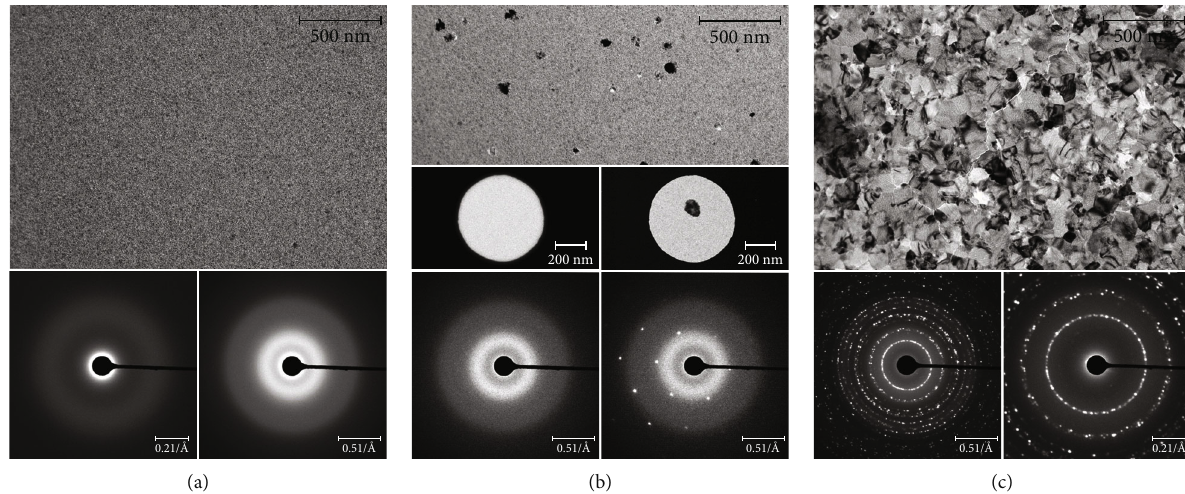
Figure 4: TEM and SAD images of TiO and 800 deposition